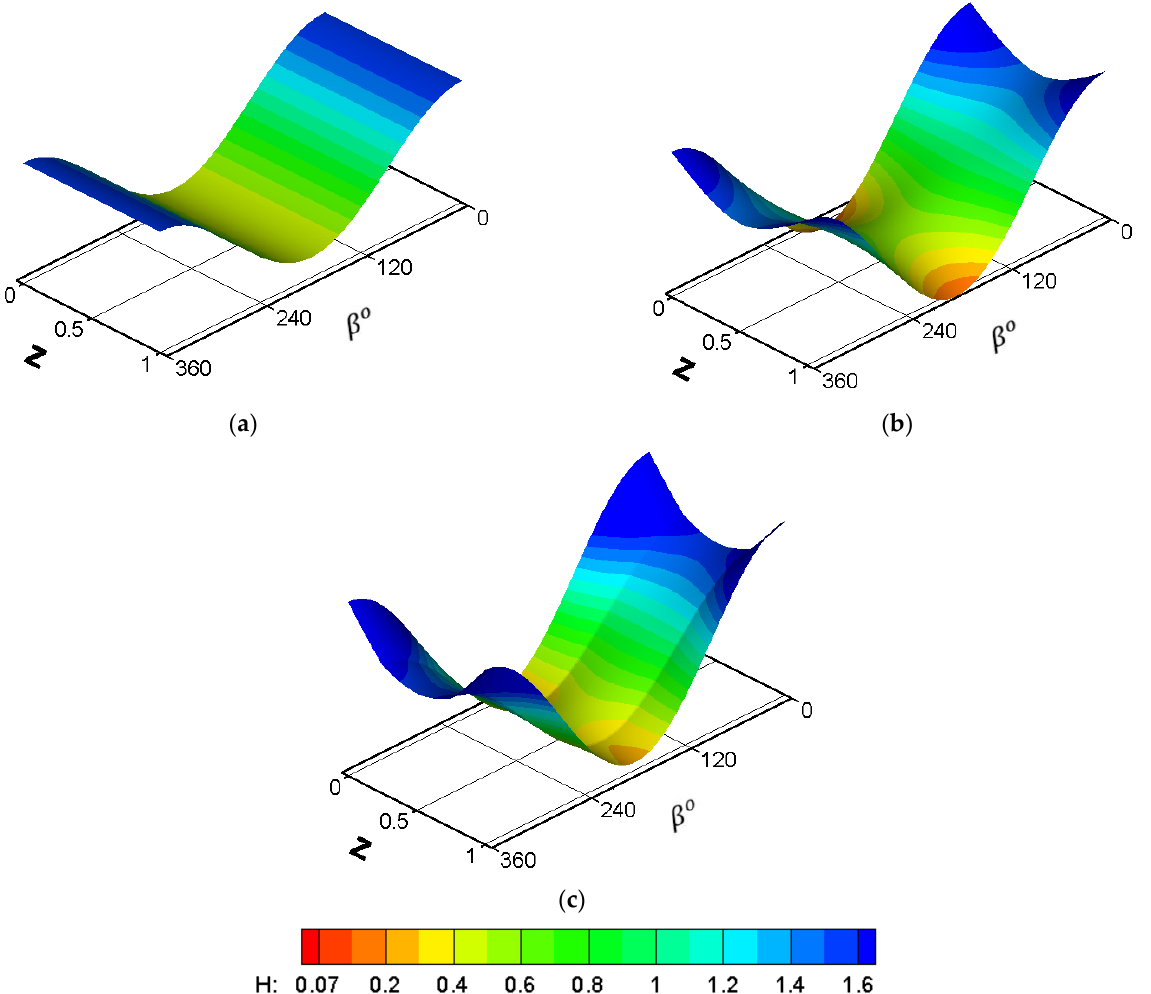
Figure 7. Dimensionless film thickness ( L / D = 1.25). ( a ): Aligned ( ∆ h o = ∆ v o = 0 ) , ( b ): misaligned ( ∆ h o = ∆ v o = 0.58 ) and ( c ): modified bearing ( ∆ h o = ∆ v o = 0.58 and A = B = 0.25 ).